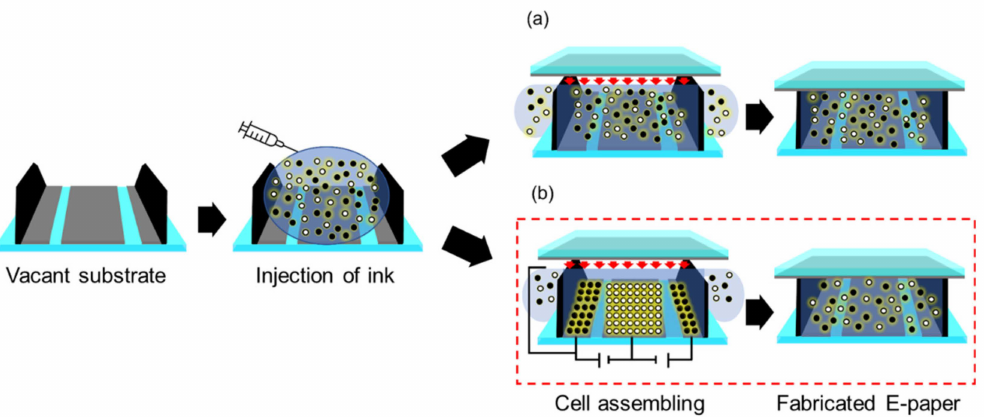
Figure 3. Fabrication procedures for loading methods of the E-ink with ( a ) conventional method and ( b ) electrophoretic particle load method.